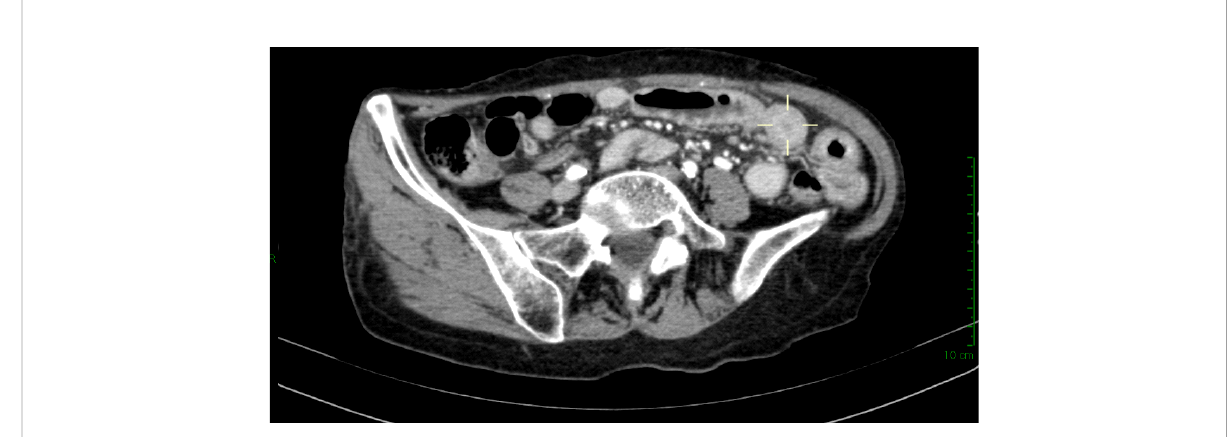
FIGURE 1 Abdominal computed tomography scan showing wall circumferential thickening (delimited by the pointer) at terminal ileum.